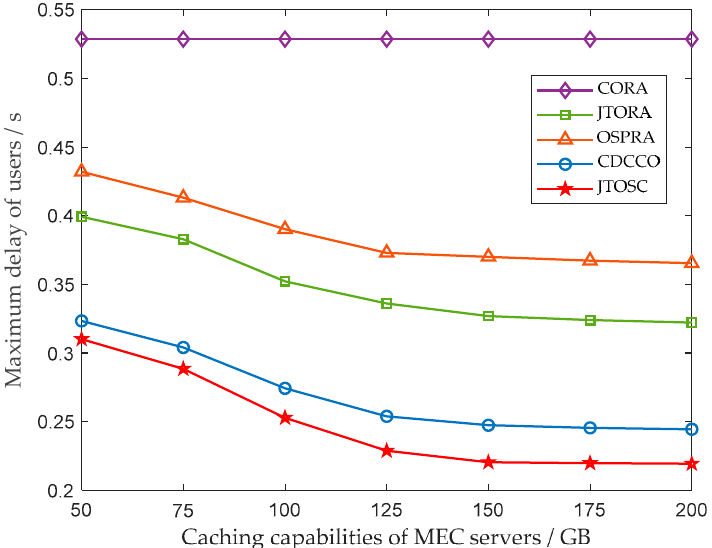
Figure 5. The impact of the caching capabilities of MEC servers on the maximum delay of users.